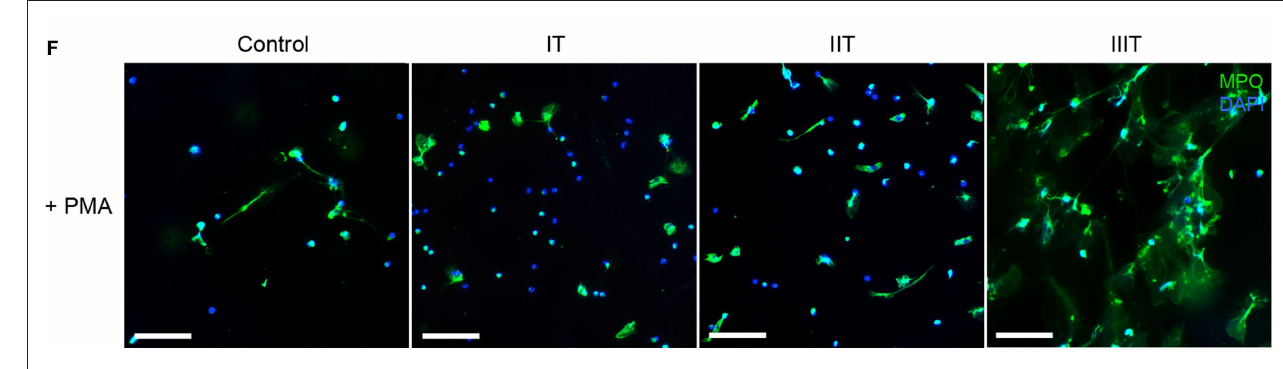
FigUre 1 | continued (a) In vitro spontaneous NET formation by neutrophils from healthy pregnant donors during the three consecutive trimesters of their pregnancies over a 3-h time course detected by fluorescence microscopy utilizing the dsDNA-binding fluorescent SytoxGreen dye. Scale bars: 100 μ m. (B) Immunofluorescence staining of neutrophils from healthy pregnant donors during the three trimesters of gestation for MPO (green) and DNA counterstain with DAPI (blue) after 3 h of culture (3 h) compared to non-pregnant healthy donors. Scale bars: 50 μ m. (c) Morphometric analysis of the NETotic and pro-NETotic primed neutrophils from healthy female controls and pregnant donors during the three trimesters of gestation at the baseline steady state (0 h) and over a 3-h time course (3 h). (D) Oxidative burst in neutrophils from healthy control donors and donors during pregnancy during the three consecutive trimesters over a 3-h time course as monitored by DCFH-DA detection. (e) Western blot and densitometric analysis of PAD4, citH3, MPO, and beta-actin protein expression levels in neutrophil lysates from healthy female controls and donors during the three trimesters of their pregnancies. (F) Fluorescent immunocytochemistry for MPO (green) and DNA counterstain with DAPI (blue) of neutrophils from healthy non-pregnant female controls and pregnant donors during the three trimesters of gestation after incubation for 2 h with 25nM of the NET-inducing agent phorbol-12-myristate-13-acetate (PMA). Scale bars: 50 μ m. Data are presented as mean ± SEM. * P < 0.05, ** P < 0.01, *** P < 0.001, and ****